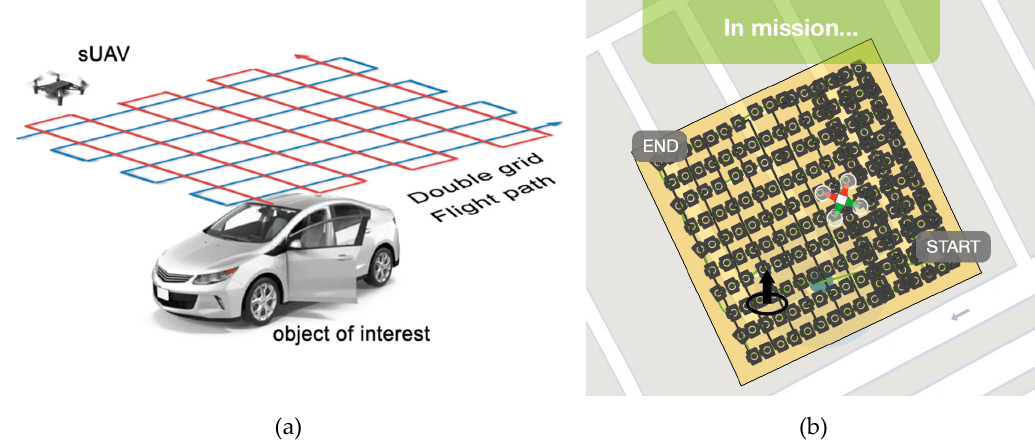
Figure 1. ( a ) Double grid flight path over an object of interest, in this case the car ( b ) double grid flight path as executed in real-time by Pix4D software.